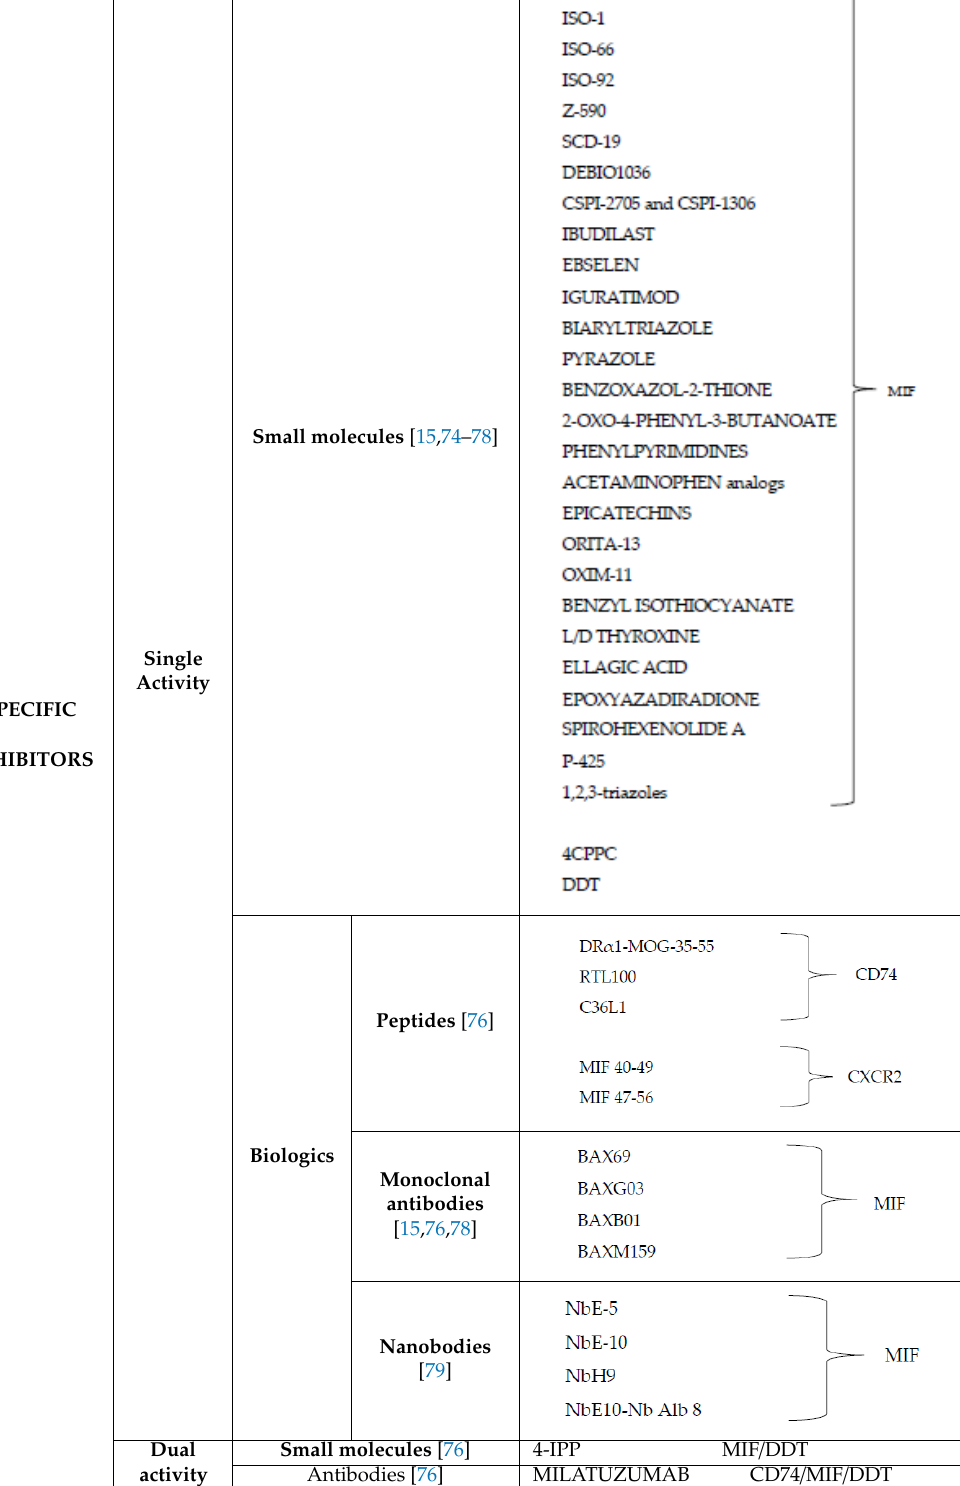
Table 1. MIF family inhibitors.